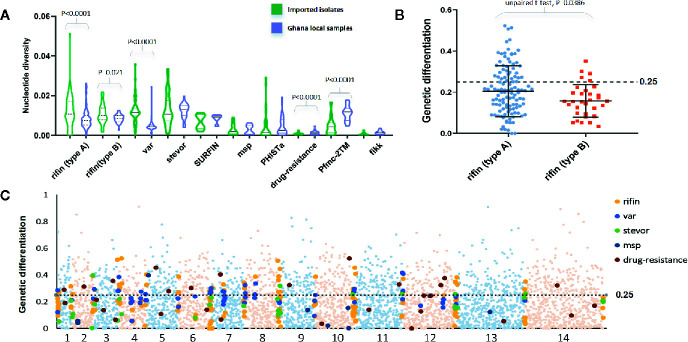

F
ST value of all genes summarizing the difference between China-imported samples (n=9) and native Ghanaian (n=92) reference samples. (A) The variation profile of some gene families exhibited greater genetic diversity between imported and local samples. (B)
F
ST value of each gene from two subgroups of the rif family showed significant differences. (C)
F
ST value in all genes for pairs of populations to explore genomic effects of local and overseas hosts.